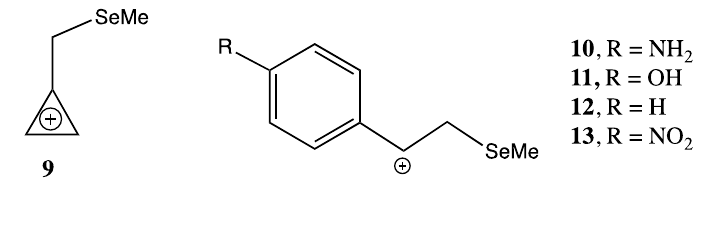
Figure 4. β -Selenium-substituted ions with higher electron